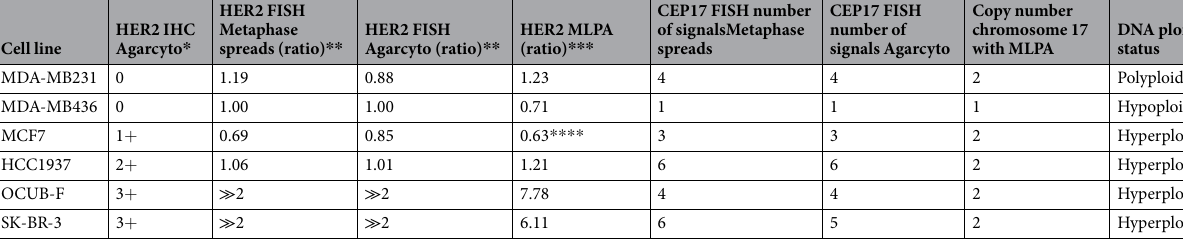
Breast cancer cell lines. The analyzed six breast cancer cell lines showed variation in HER2 status (Table 1, Figs 1 and 2): two were amplified and four cell lines were not. There was perfect correlation of the HER2 status when comparing MLPA, IHC, FISH on cells and on metaphase spreads in all cell lines. Gain of CEP17 was detected in five of six cell lines with FISH, in both the metaphase spreads and interphase cell nuclei. However, not one cell line showed isolated polysomy of chromosome 17 in the MLPA test (Fig. 2). Especially in metaphase spreads, copy number gain of the whole chromosome 17, and not only of the centromeric region could be appreciated (Fig. 1). Copy number gain of chromosome 17 correlated with a tetraploid or aneu- ploid pattern with gains in the DNA ploidy assessment in five of six cell lines (three DNA histograms are shown in Fig. 3. These data show that copy number gain of CEP17 is not due to isolated chromosome 17 polysomy, but is a result of aneuploidy with gain of multiple chromosomes.